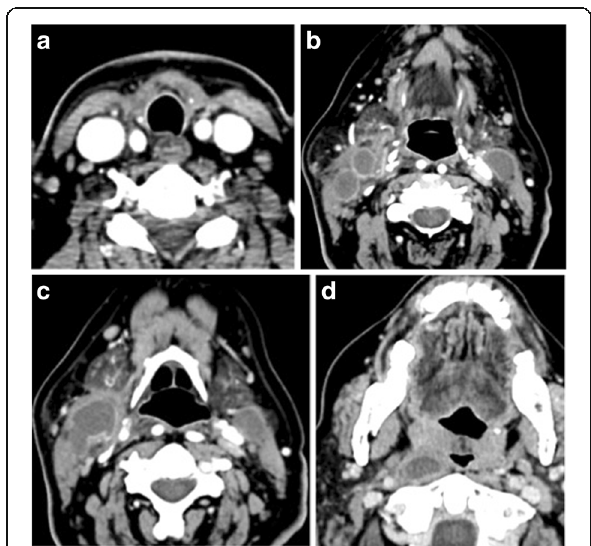
Fig. 4 A case of 63-year-woman of prior old (10 years ago) of operated thyroid cancer with multiple questionable cervical nodal swellings. ( a ) Shows clear thyroidectomy bed. ( a and b ) Shows grouped bilateral markedly necrotic nodes with smooth regular iso to mild hyper- enhancing smooth and thin margin, at levels II mainly with grouping and near conglomeration. A right-sided retropharyngeal node is seen ( c ). Features are in favor of being squamous cell carcinoma metastatic nodes over the non-squamous cell cancer nodes, putting down the possibility of thyroid recurrence. ( d ) Shows the primary oropharyngeal primary squamous cell carcinoma proved later. The signs helped to differentiate a